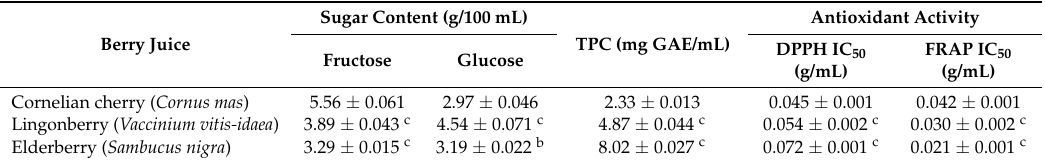
Table 1. Sugar content and antioxidant properties of investigated fruit